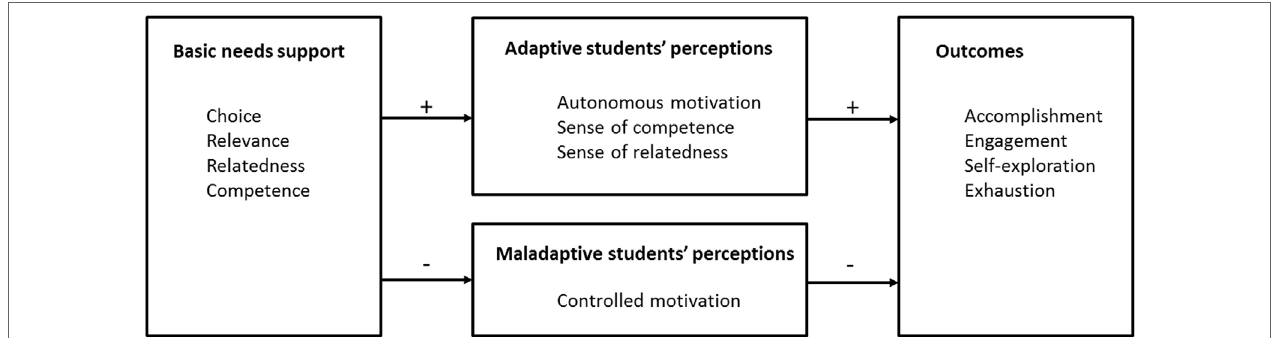
FigUre 1 | Conceptual model of research